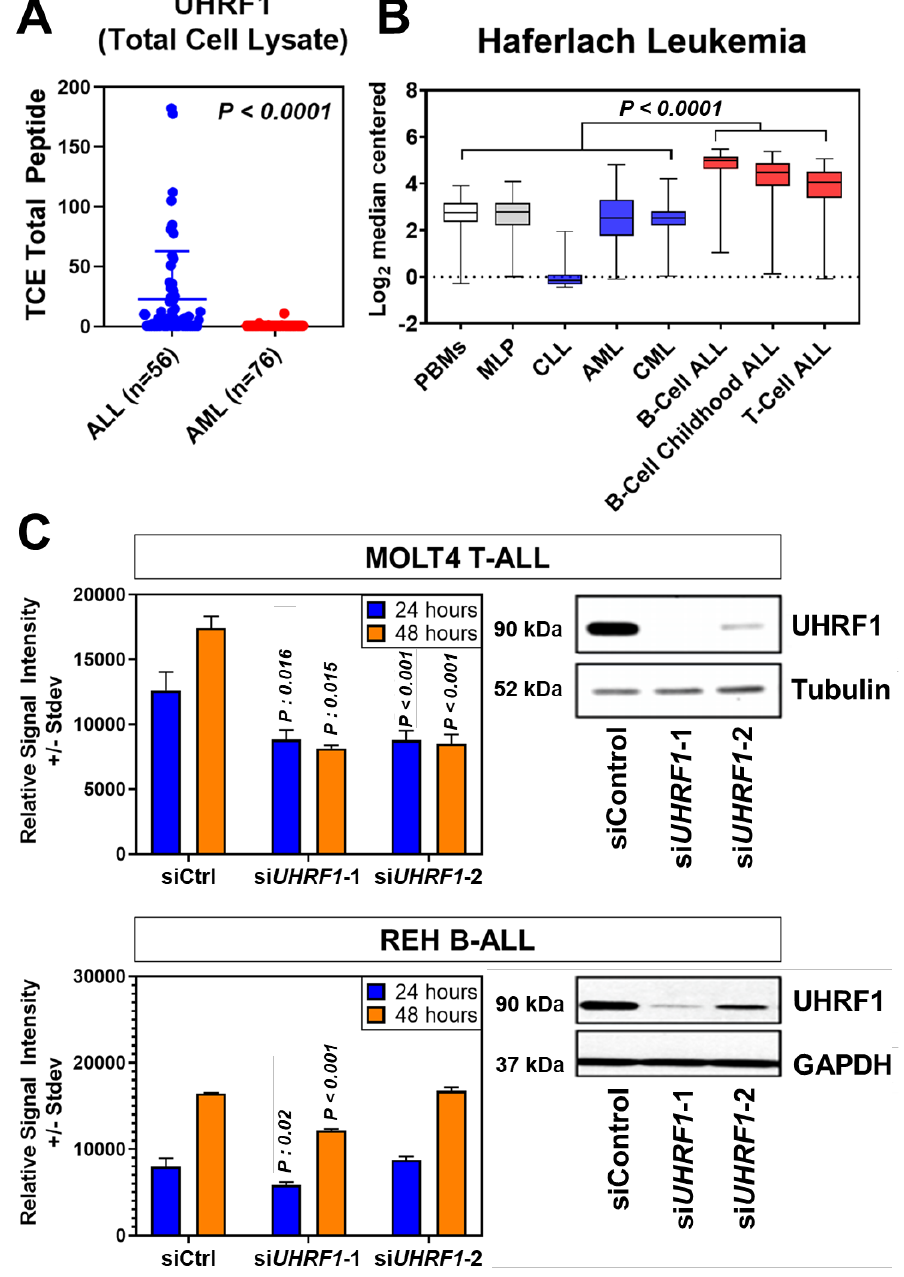
Figure 1. UHRF1 protein and gene expression in leukemia subtypes and their knockdown effects on cell proliferation. ( A ) Scatter plot of UHRF1 protein expression in patient-derived primary ALL ( n = 56) and AML samples ( n = 76). p = 0.0001 vs. AML samples based on mass spectrometry spectral counts of UHRF1 tryptic peptides. ( B ) Haferlach Leukemia Cohort transcriptomic dataset was used to evaluate the expression of UHRF1 in different subtypes of leukemia. ( C ) Knockdown efficiency of UHRF1 siRNA in MOLT4 (T-ALL) cells. siRNA knockdown efficiency was confirmed after 48 h by immunoblotting, and an MTS assay was performed at 24 and 48 h after transfection. Each experiment was performed in triplicate ( n = 3). The uncropped blots are shown in Figure